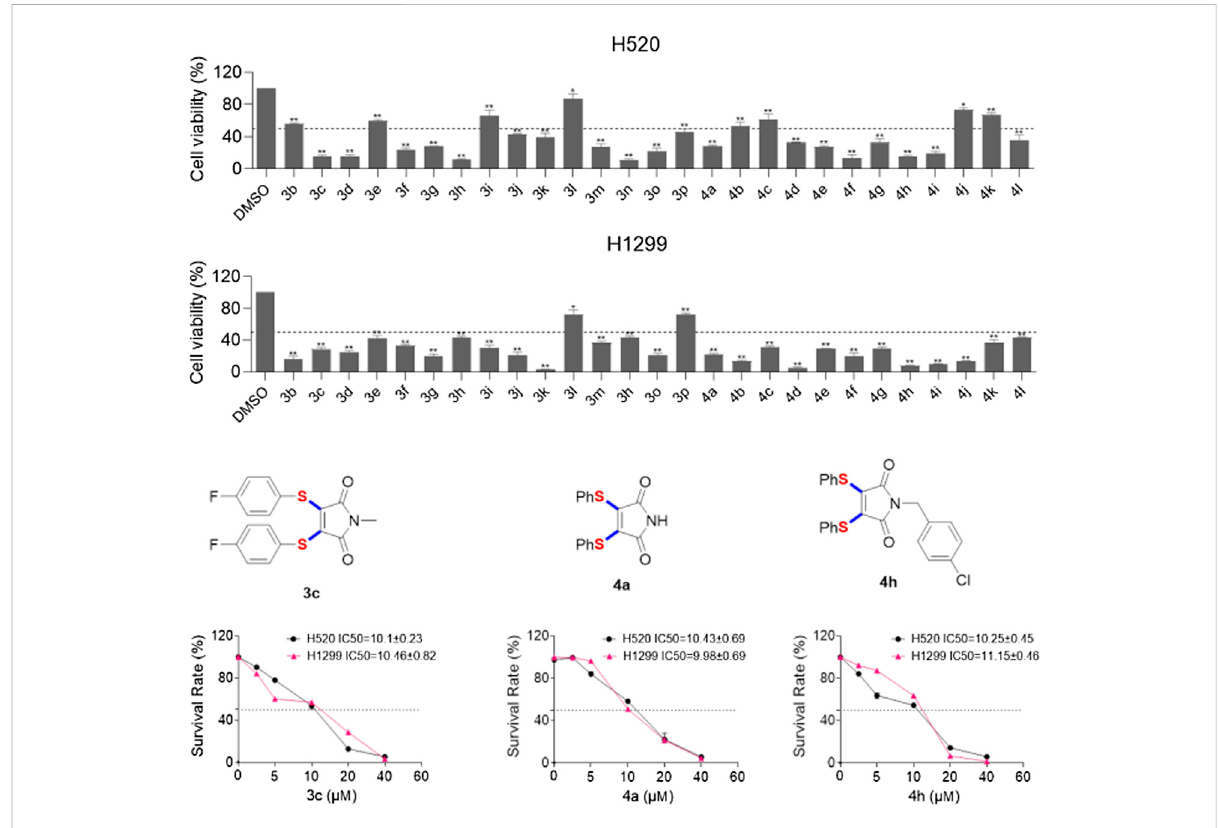
Anticancer activity of 3,4-diarylthiolated